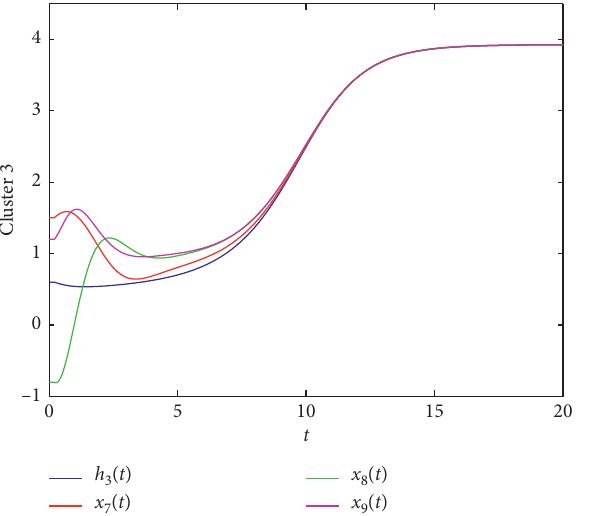
Figure 9: The state trajectories in cluster